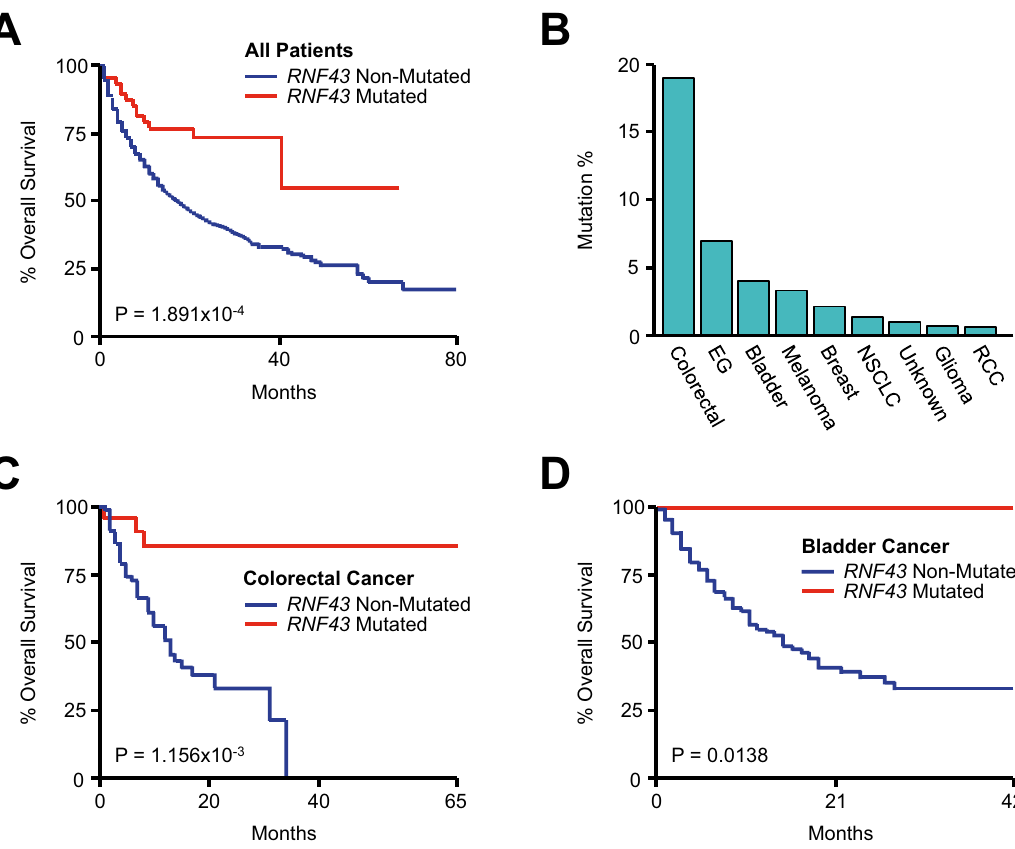
Figure 4. RNF43 mutations are associated with improved survival in colorectal and bladder cancer patients receiving immune checkpoint inhibitors. ( A ) Kaplan Meier plot showing overall survival for the pan-cancer cohort (N = 1661) arranged by RNF43 mutation status (61 RNF43 -mutated and 1600 RNF43 -non-mutated patients). ( B ) The percent of RNF43 -mutated patients arranged by tumor type. ( C , D ) Overall survival for the colorectal (N = 110, 22 RNF43 -mutated and 88 RNF43 -non-mutated patients) and bladder cancer (N = 215, 9 RNF43 -mutated and 206 RNF43 -non-mutated patients) cohorts arranged by RNF43 mutation